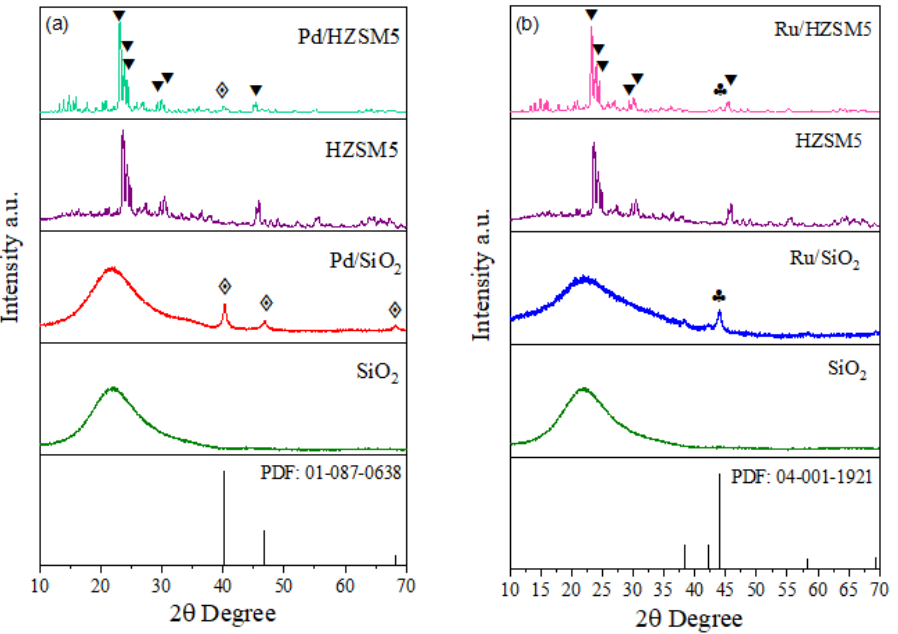
Figure 2. Diffractograms of ( a ) supports and Pd-based catalysts, ( b ) supports and Ru-based catalysts. ( ) HZSM5, ( ) Pd 0 , and ( ) Ru 0 . STEM images of Pd/SiO 2 , Pd/HZSM5, Ru/SiO 2, and Ru/HZSM5, as well as the respec-